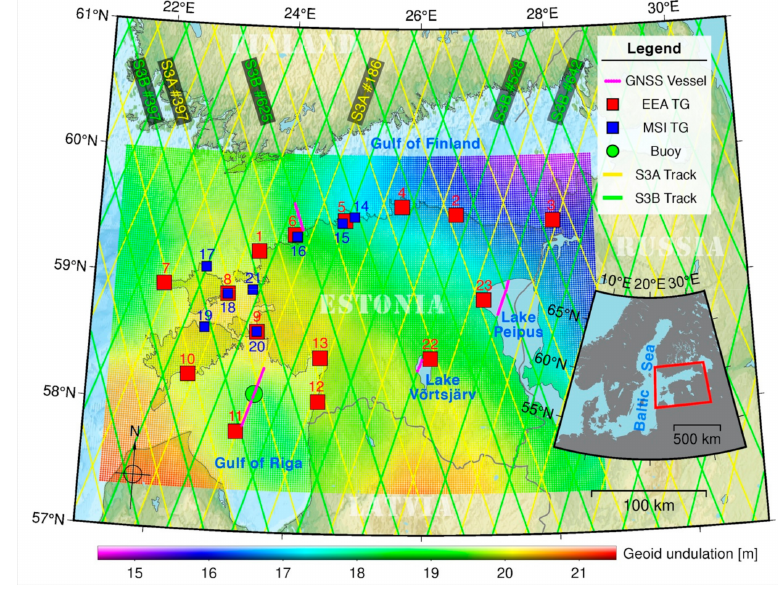
Figure 2. Study area with Sentinel-3A (S3A) and Sentinel-3B (S3B) ground tracks, tide gauges (red and blue squares), a buoy (green circle) and four GNSS tracks (magenta lines). The labelled Sentinel-3 ground tracks were used for validation. The tide gauges are operated by the Estonian Environmental Agency (EEA TG) and the Department of Marine Systems of Tallinn University of Technology (MSI TG). Estonian geoid model EST-GEOID2017 is laid over